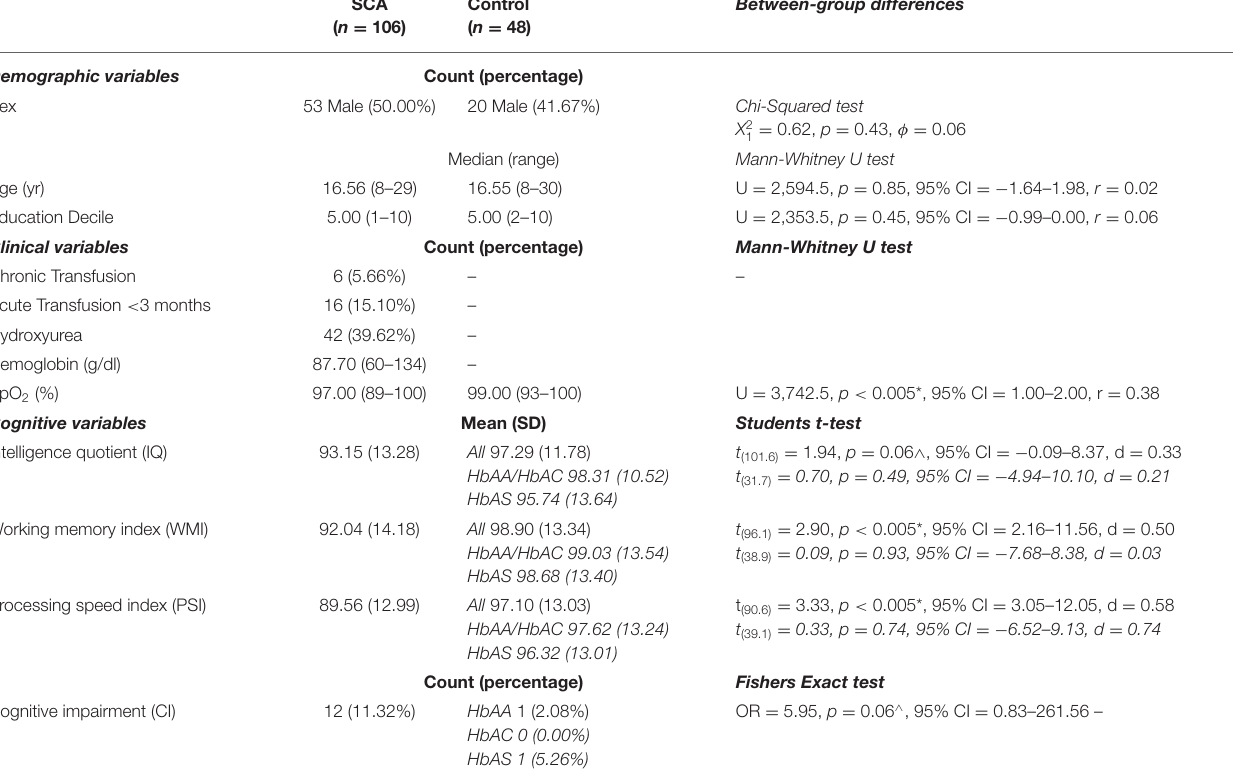
TABLE 2 | Sample demographics and cognitive